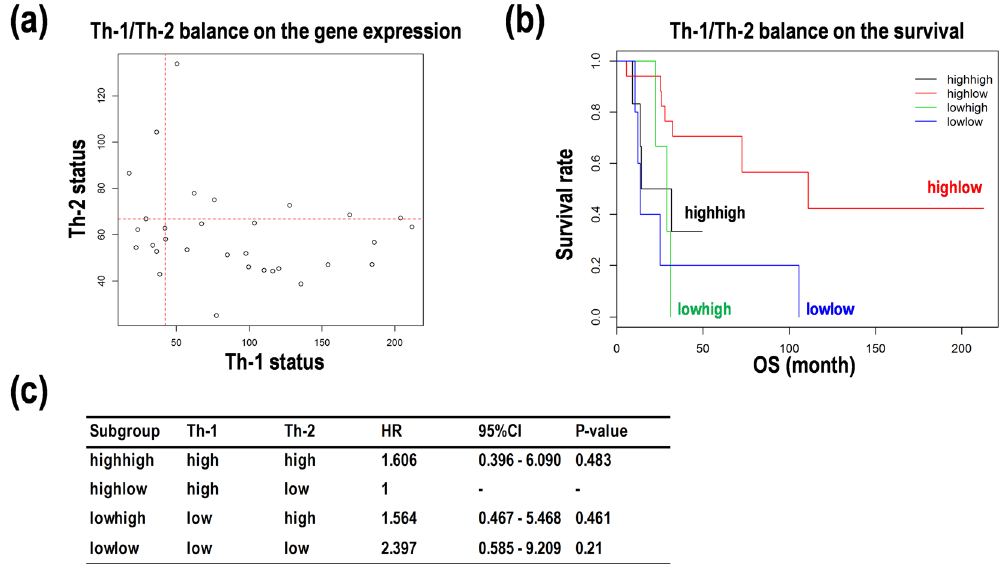
Figure 3. Balance of T helper cell type 1/2 (Th-1/Th-2) predicts prognoses in primary central nervous system lymphoma (PCNSL). ( a ) The balance of Th-1 and Th-2 status in scatter plot. ( b ) Kaplan-Meier analysis on the survival prediction formula in PCNSL patients. The patients were divided into four subgroups with Th-1 high Th- 2 high (black), Th-1 high Th-2 low (red), Th-1 low Th-2 high (green), and Th-1 low Th-2 low (blue) by the median score calculated on the formula. OS; overall survival. ( c ) Comparison of risk in survival of PCNSL with Th-1/Th-2 balance. Hazard ratio (HR) with 95% confidence interval (CI) compared with the Th1 high Th2 low